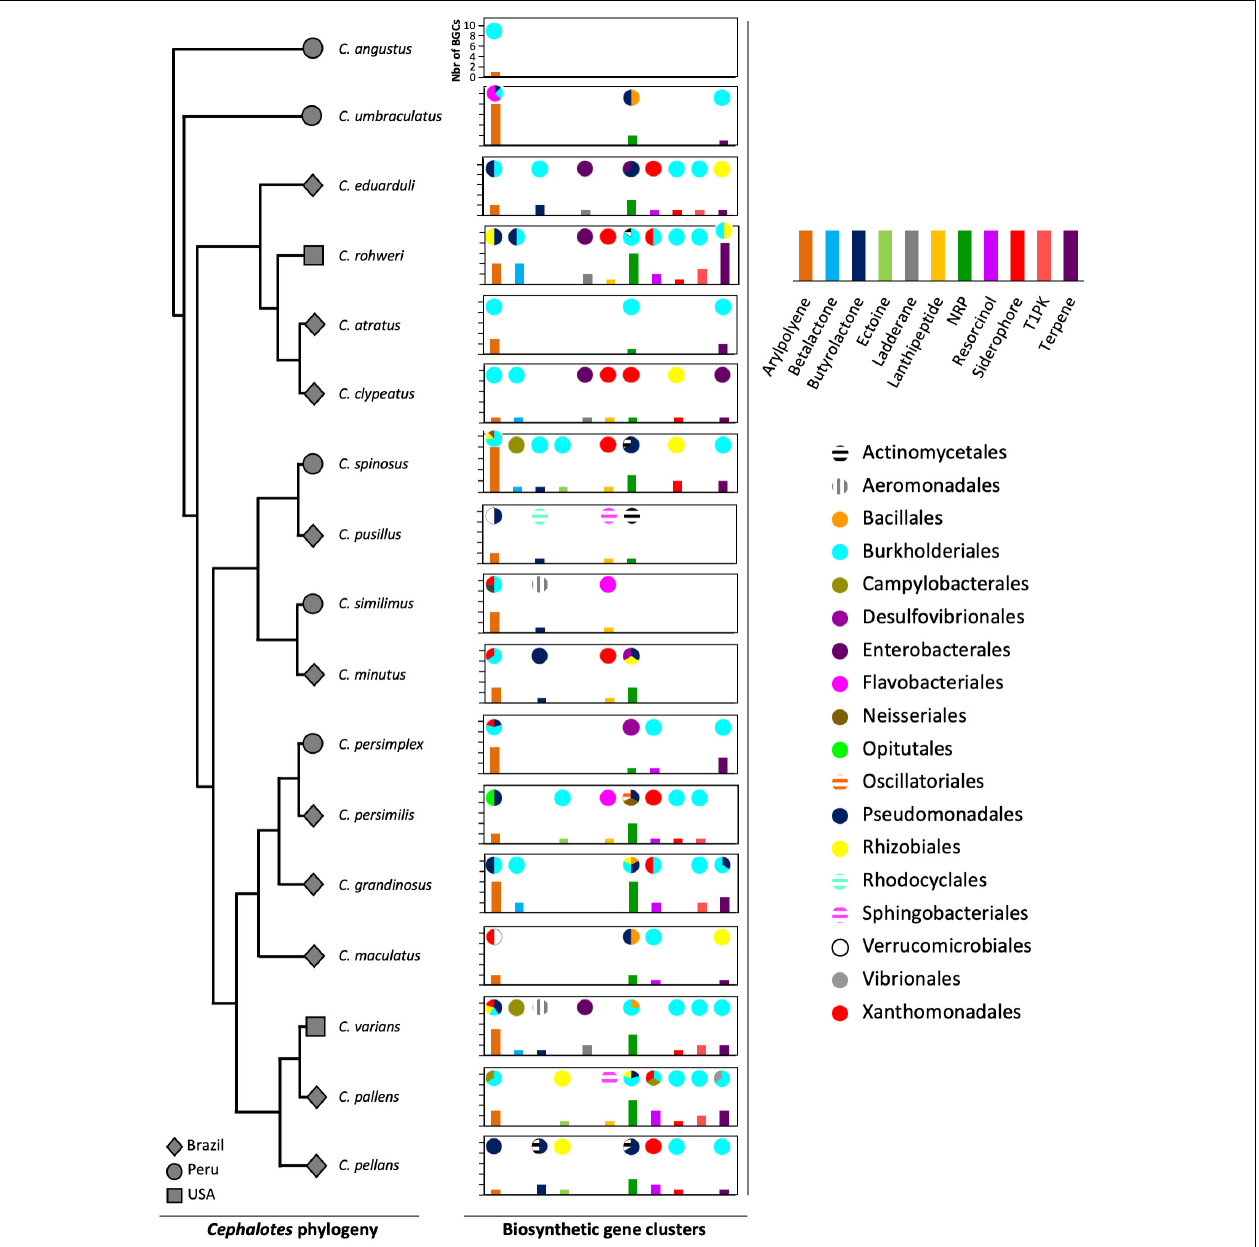
FIGURE 1 | Diversity of BGCs of bacteria associated with Cephalotes turtle ants. The gray symbols represent the country from which an ant originated. The graphs represent the bacterial BGCs found in the metagenomes of each Cephalotes species in this study. The bars of the graphs represent the number of BGCs of each type found in the metagenomes. The pies represent the proportion of bacterial orders from which each BGC type